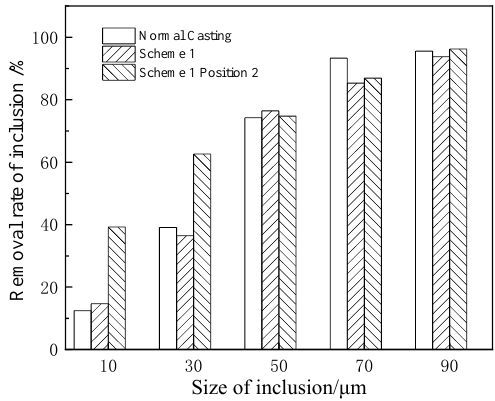
Table 5. Numerical result of RTD curves in tundish with each scheme.